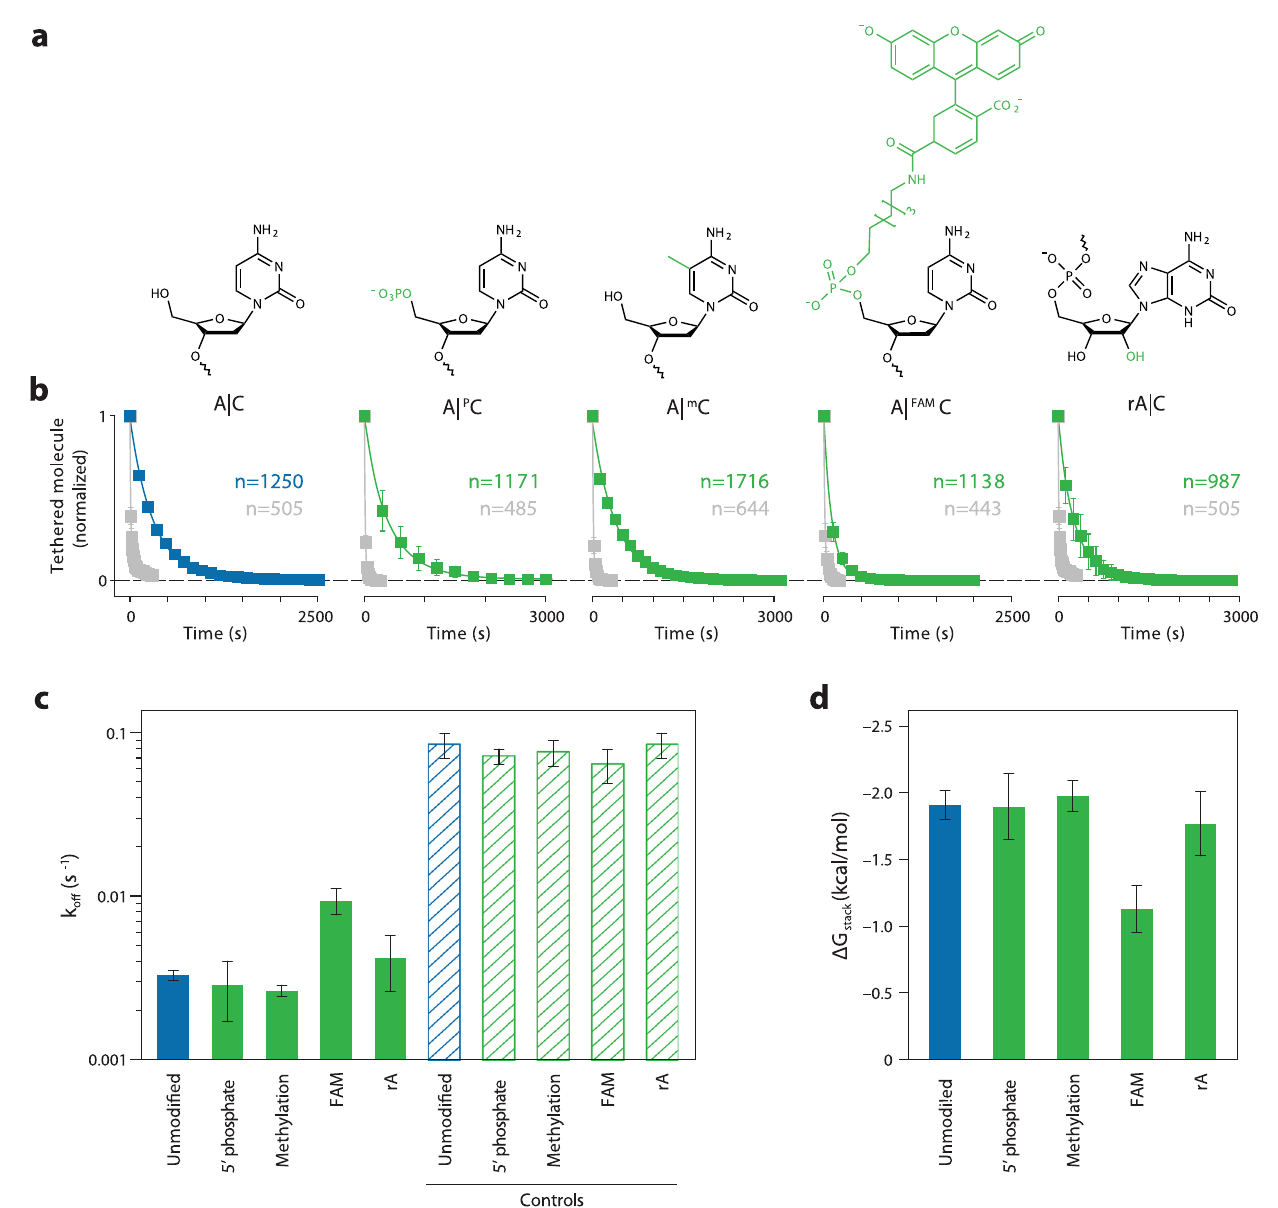
Fig. 5 | Effect of nucleotide modi fi cation on base stacking energy of nucleo- tides. a Modi fi cationsusedin the studyincluding 5 ′ Phosphorylated C,5-methylC,